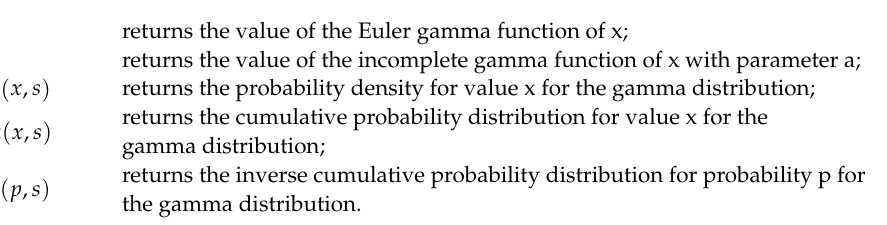
The frequency factor for L-moments can be estimated using a polynomial function: